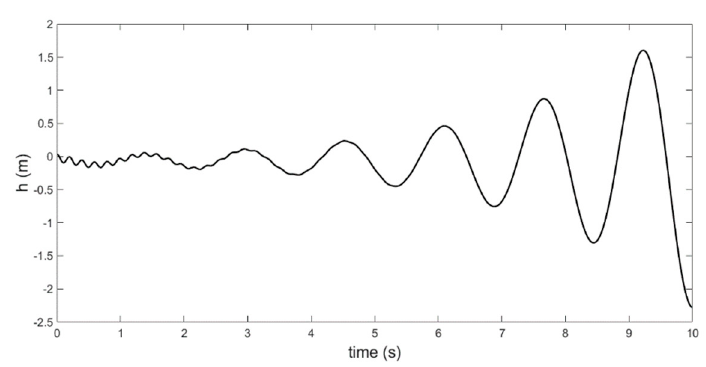
Figure 13. Time response of “h” in upper speed of flutter (35 m/s).